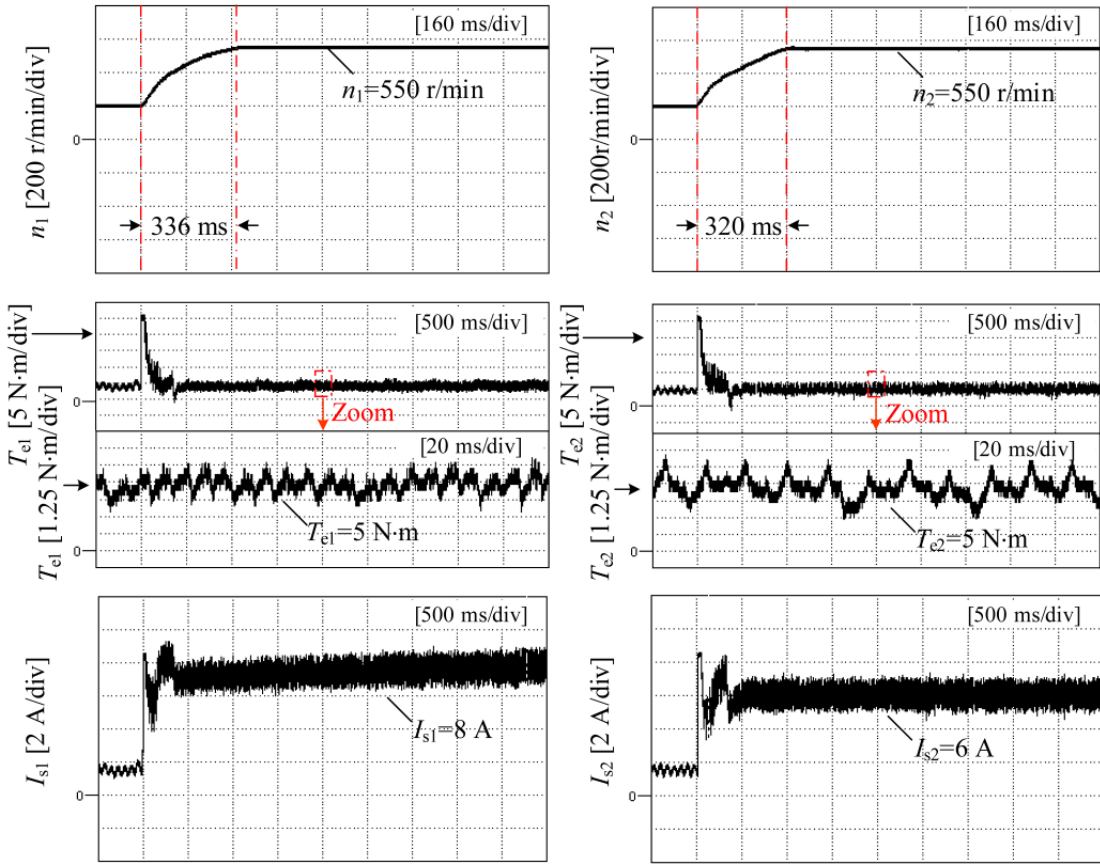
Figure 16. Waveform comparison diagram of only PART_1 control and PART_1+PART_2 control.